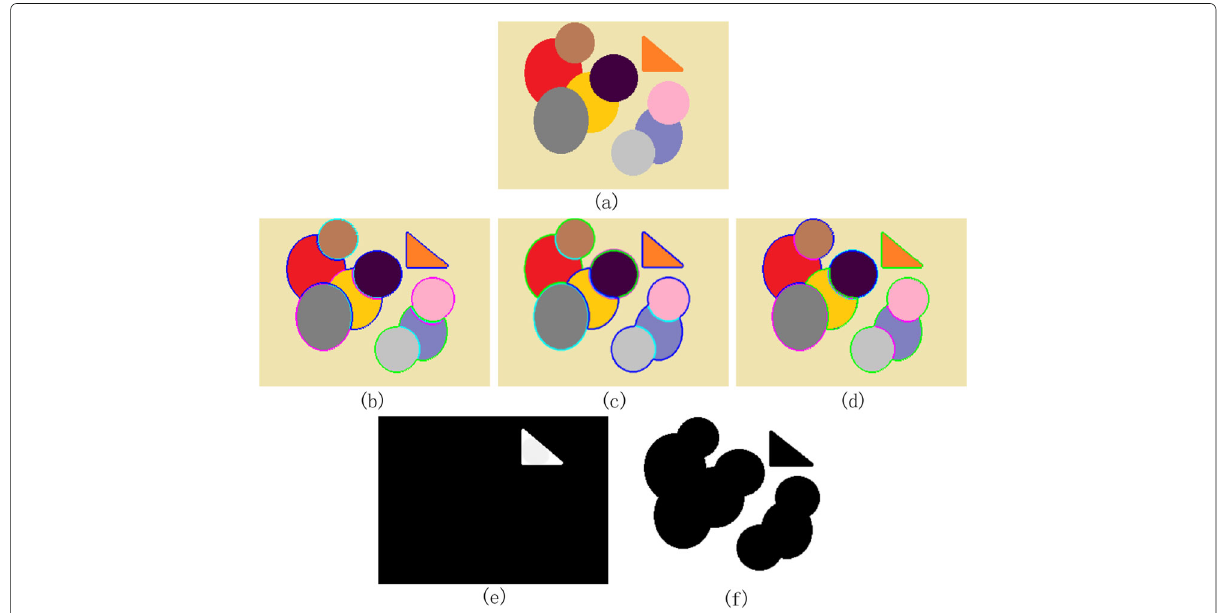
Fig. 12 Ten-phase segmentation of a color image. a The input color synthetic image. b The segmentation of original Vese-Chan method. c The segmentation of TV regularization method. d The segmentation of our model. e – f Two meaningful regions obtained via our